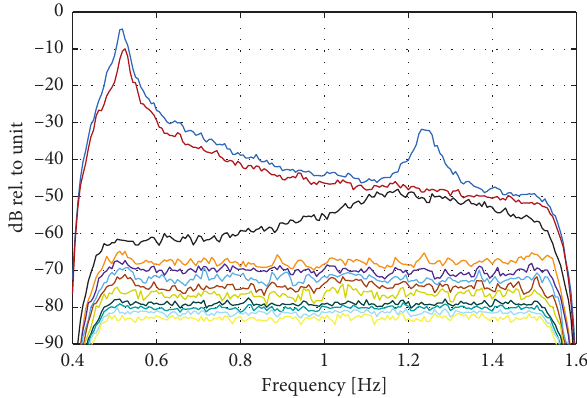
Figure 4: Singular values of spectral density. Table 2: Comparison between experimental and numerical modal properties.